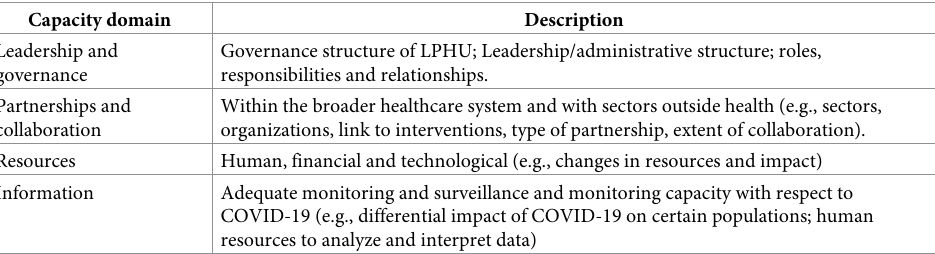
Table 3. Domains of LPHU capacity to address